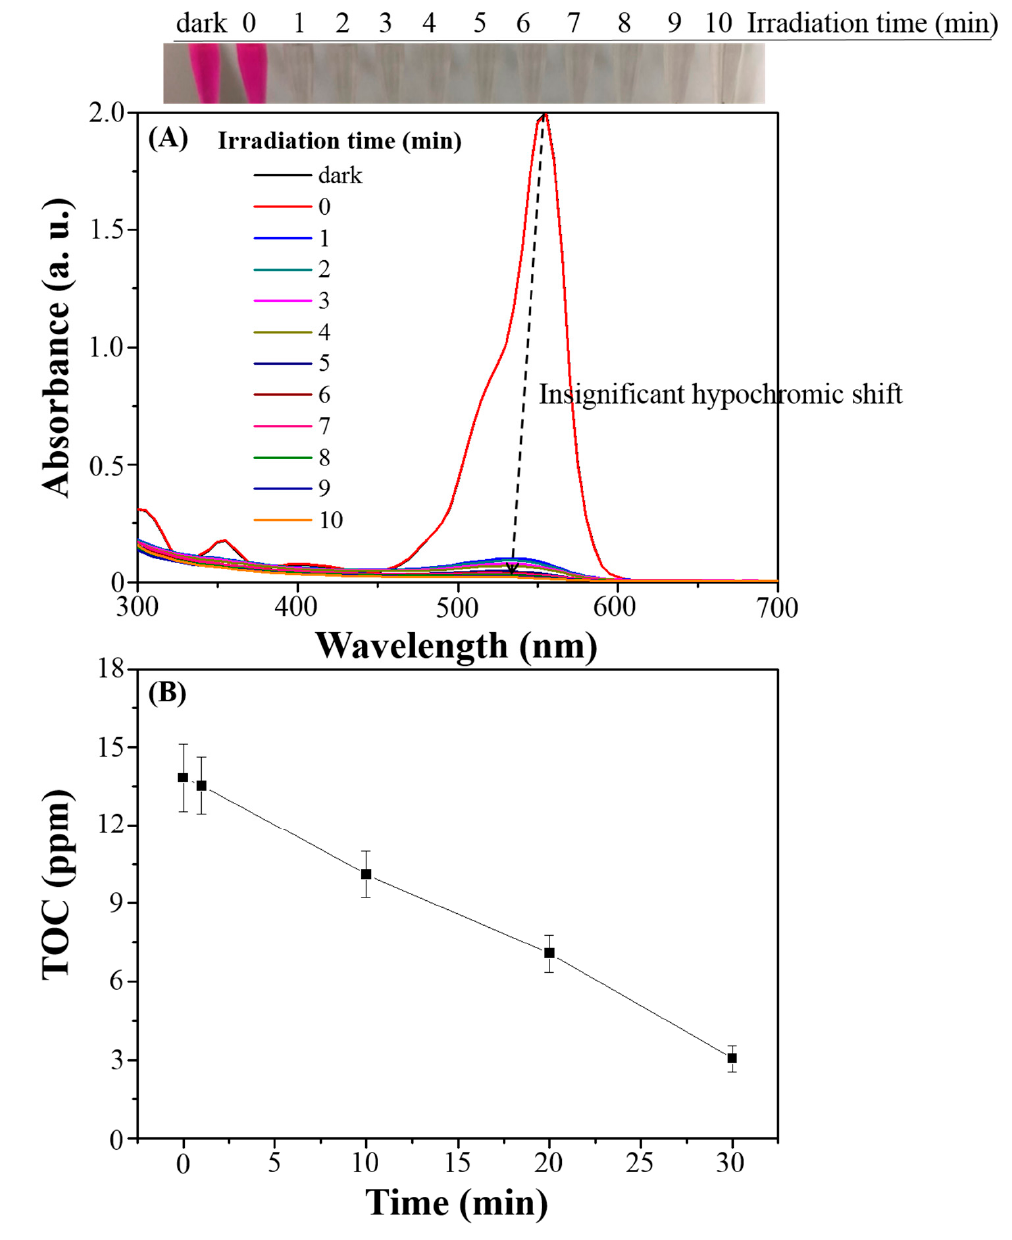
Figure 12. ( A ) Temporal evolution of UV–Vis spectra of RhB and ( B ) the corresponding total organic carbon (TOC) content of RhB degradation by the prepared CuFeS 2 / Ag 3 PO 4 composites through the photo-Fenton reaction. Top image: photographs of the RhB solution under the photo-Fenton reaction at different irradiation time.